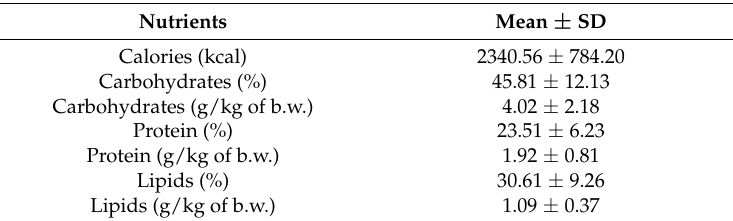
Table 2. Food intake of runners.